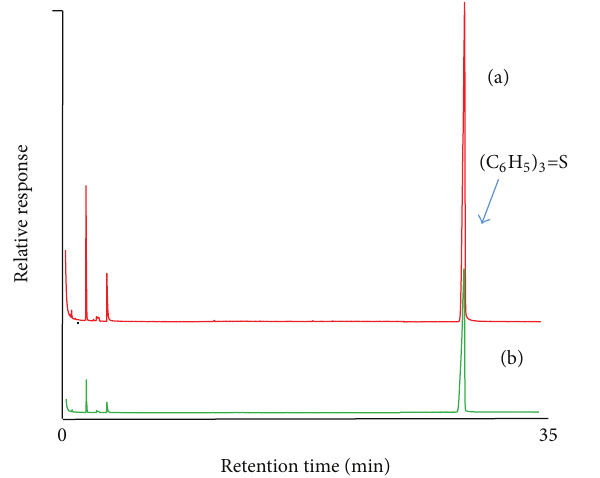
Figure 4: SBME extracted chromatograms after (a) Arabian crude oil by thick-walled hollow fiber membrane and (b) Arabian crude oil by conventional hollow fiber membrane (thinner wall